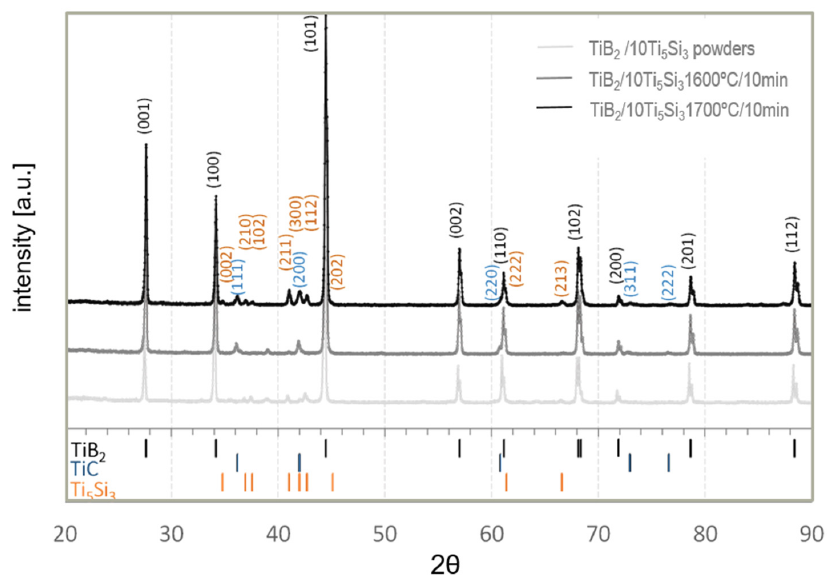
Figure 3. XRD patterns, registered in BB geometry of the TiB 2 + 10 wt % Ti 5 Si 3 powder mixture after homogenization, and the TiB 2 /10Ti 5 Si 3 composites (1600 ° C and 1700 ° C) with indexed peak positions for the identified phases. ICDD (ref. code) used for the identification of TiB 2 (01-075-1045), Ti 5 Si 3 (01-078-1429) and TiC (03-065-8805).